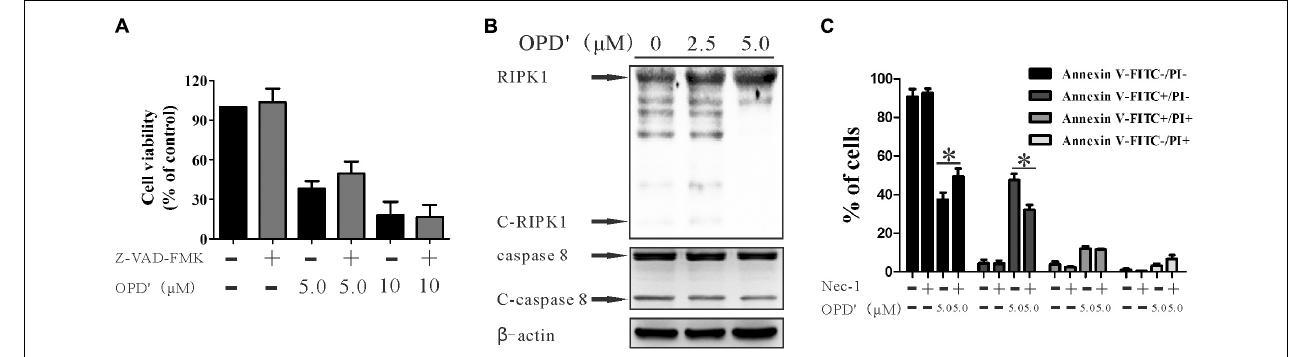
FIGURE 3 | OPD (cid:48) induced early apoptosis through the RIPK1 pathway, not the caspase pathway. (A) After being pre-treated with 20 µ M Z-VAD-FMK (a caspase inhibitor) for 2 h, the PC3 cells were exposed to various concentrations of OPD (cid:48) for 24 h, followed by the CCK-8 assay. Data are presented as the means ± SD; n = 3 independent experiments. (B) PC3 cells were exposed to various concentrations of OPD (cid:48) for 6 h, then target proteins (RIPK1, C-RIPK1, caspase-8, and C-caspase-8) were examined by Western blotting. n = 3 independent experiments; this panel is one of these replicates. (C) After pre-treatment with 10 µ M Nec-1 (a specific inhibitor of the RIP1 kinase domain) for 2 h, PC3 cells were exposed to various concentrations of OPD (cid:48) for 18 h, followed by the Annexin V-FITC/PI assay. Data are presented as the means ± SD; n = 3 independent experiments. ∗ p < 0.05 vs. treatment with 5 µ M OPD (cid:48) alone.